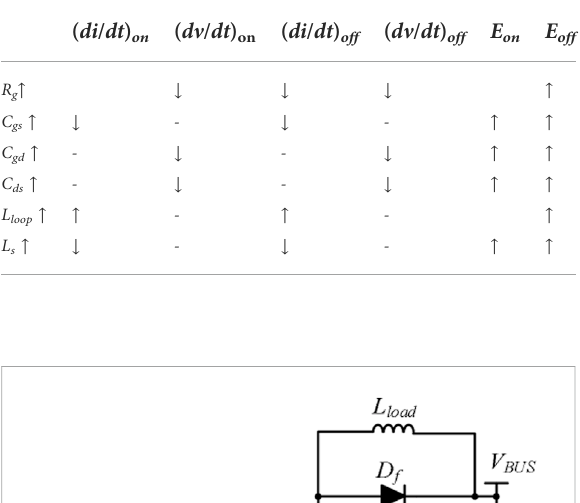
TABLE 2 In fl uences of circuit parameters on the switching behaviors.